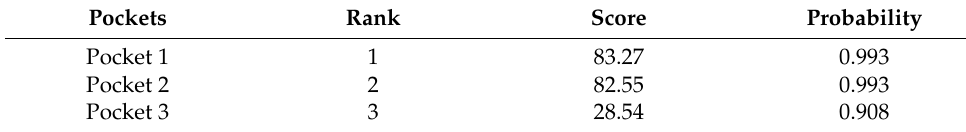
Figure 3. PHF Tau structure with spheres representing the different binding pockets. Green spheres show pocket 1, red spheres represent pocket 2 and yellow spheres show pocket 3. Table 1. Binding pocket scores for the LRP1 sequence obtained from PrankWeb.